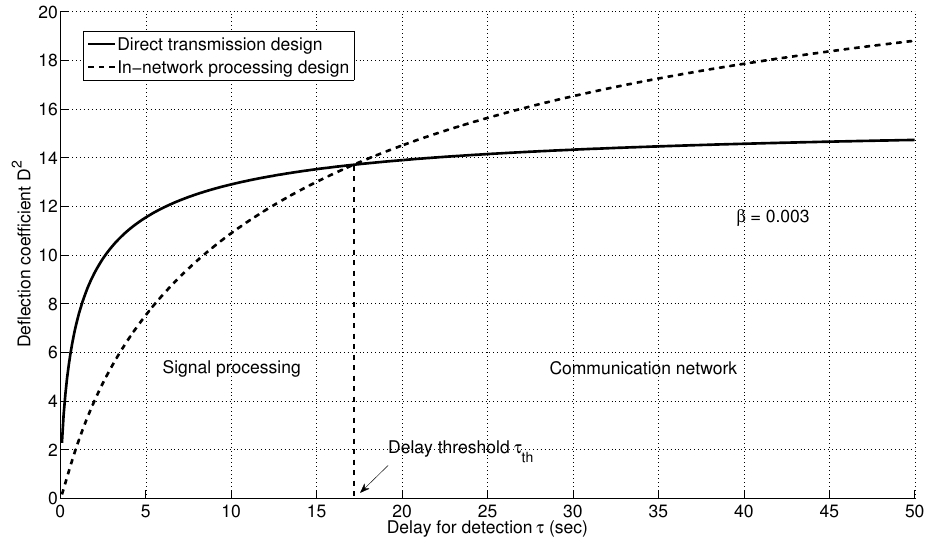
Figure 15. Deflection coefficient for direct transmission and in-network processing